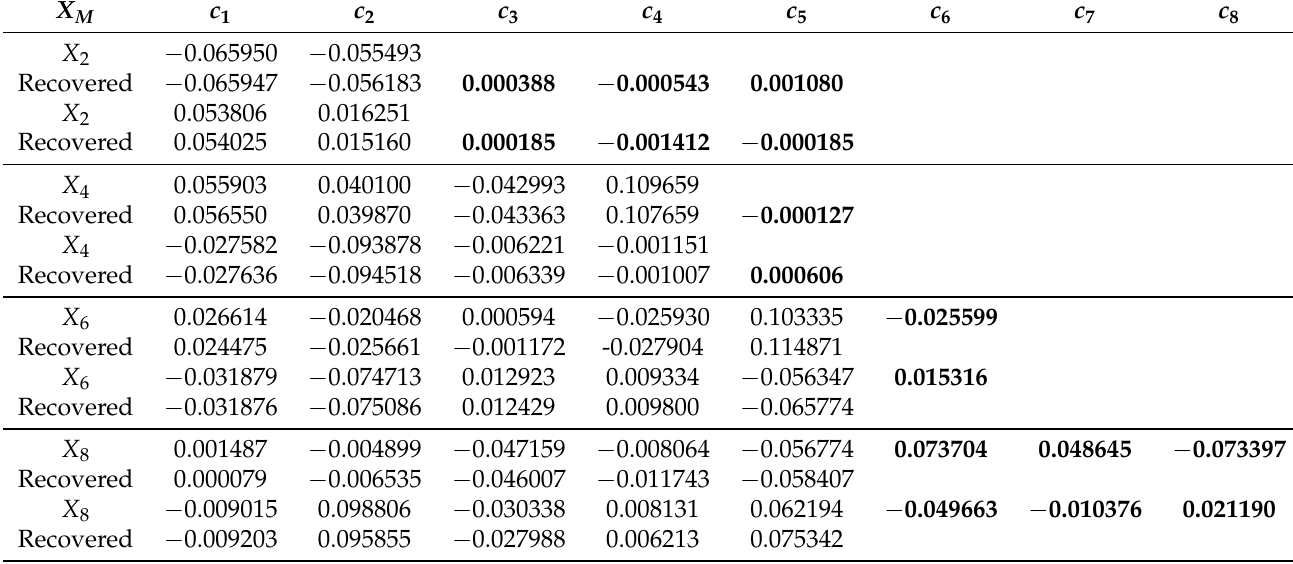
Table 2. Actual coefficients c m of 1 − q ( r ) for q ∈ X M ( M = 2,4, 6,8 ) and recovered coefficients from the trained model for X 5 with k = 7. The trained model for X 5 can recover c m only for 1 ≤ m ≤ 5. The recovered coefficients c 3 , c 4 , c 5 in X 2 and c 5 in X 4 are very small. In the case of X 6 and X 8 , the trained model is able to recover c m ( 1 ≤ m ≤ 5 ) successfully and ignores the other coefficients c m ( m > 5 )